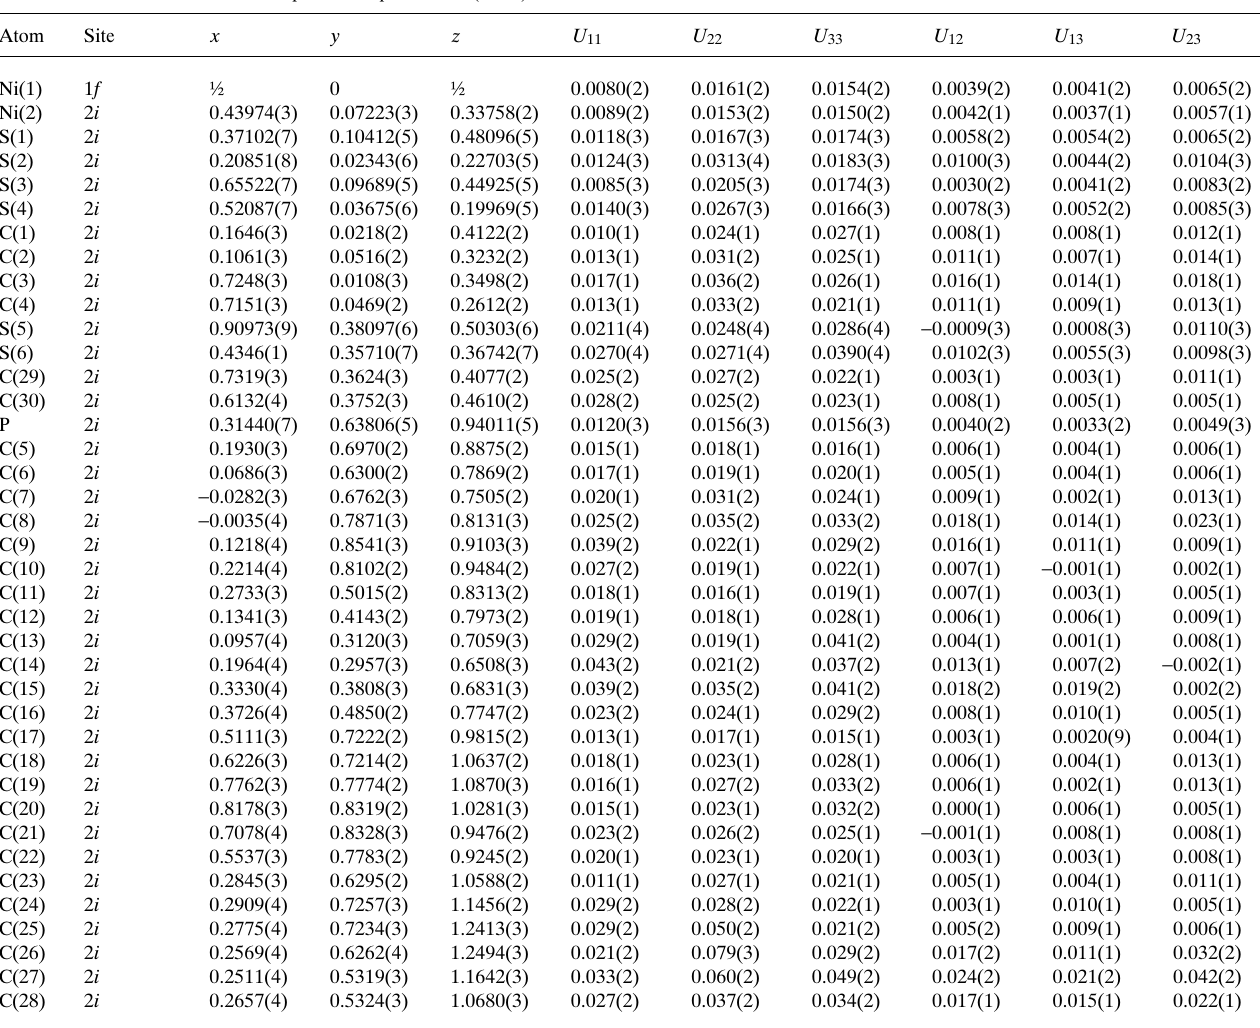
Table 3. Atomic coordinates and displacement parameters (in Å 2 ) .